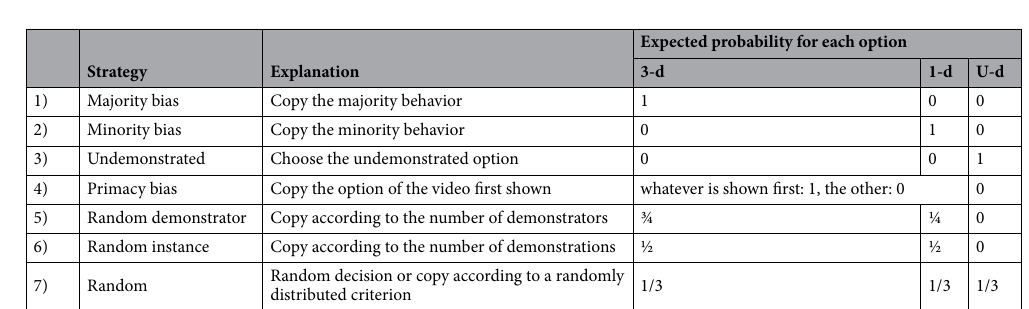
Table 1. Expected probabilities of observed responses in the experiment, based on an assumed underlying